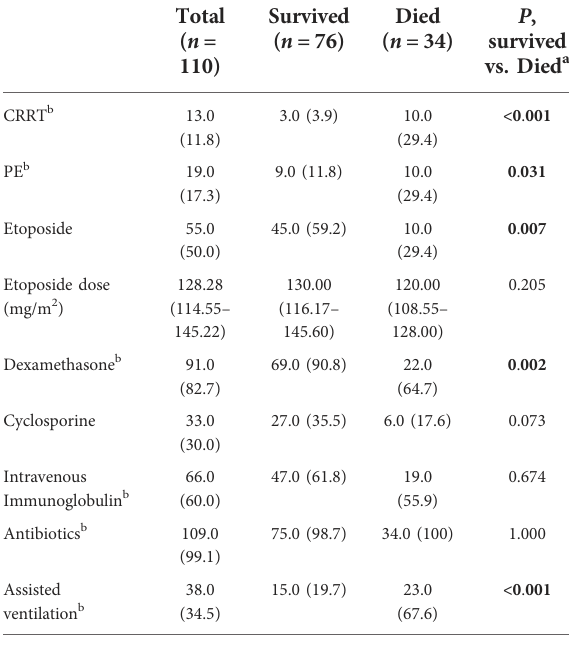
TABLE 3 Statistics of therapeutic strategies in 110 patients with HLH according to survival